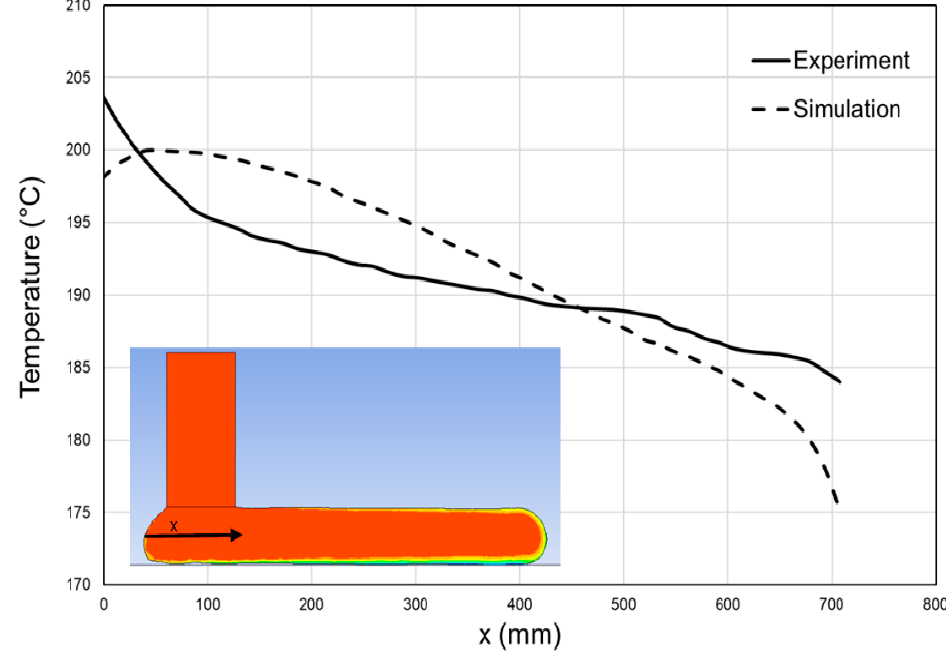
Figure 12. Model predictions and experimental data of temperatures along the mid-axis of a single layer deposited. The inset shows the origin of the x axis, located right underneath the nozzle along the middle plane of the deposited layer.